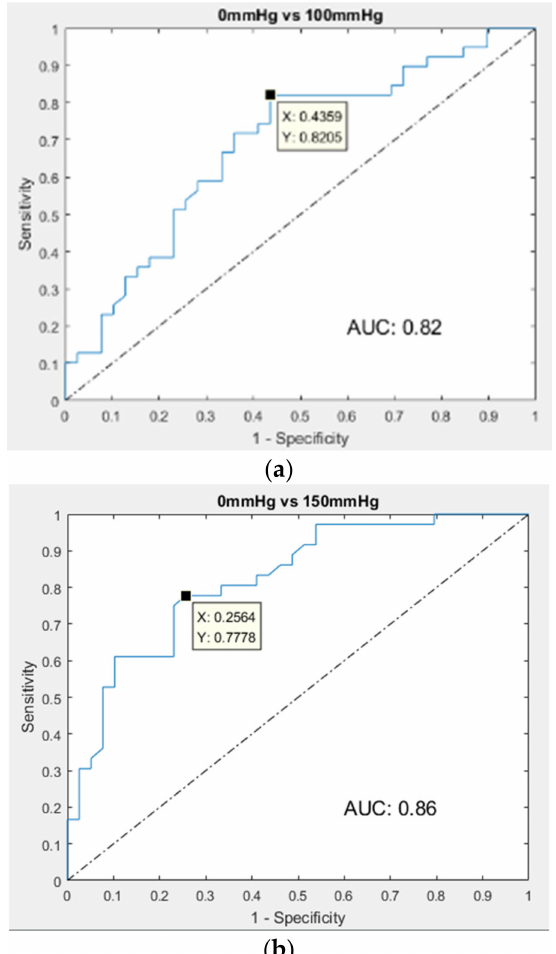
Figure 9. ROC curves of m 40 : ( a ) the area under the curve is 0.82 in the slight DVT scenario, ( b ) the area under the curve is 0.86 in the serious DVT